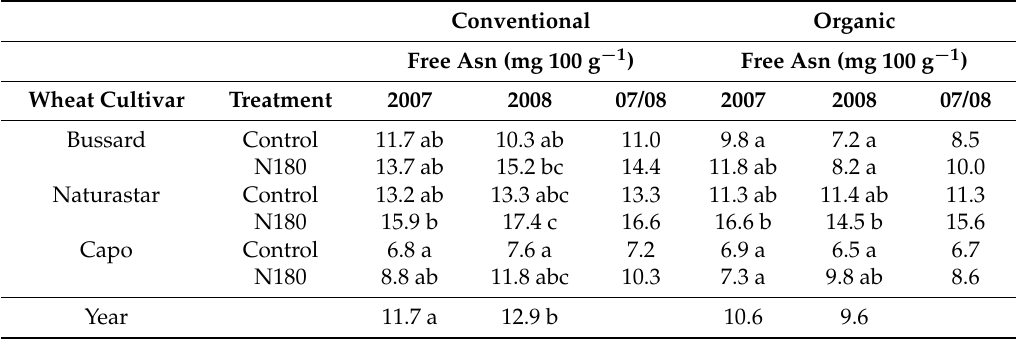
Table 6. Free Asn content of conventionally and organically grown winter wheat cultivars separated by N treatment and